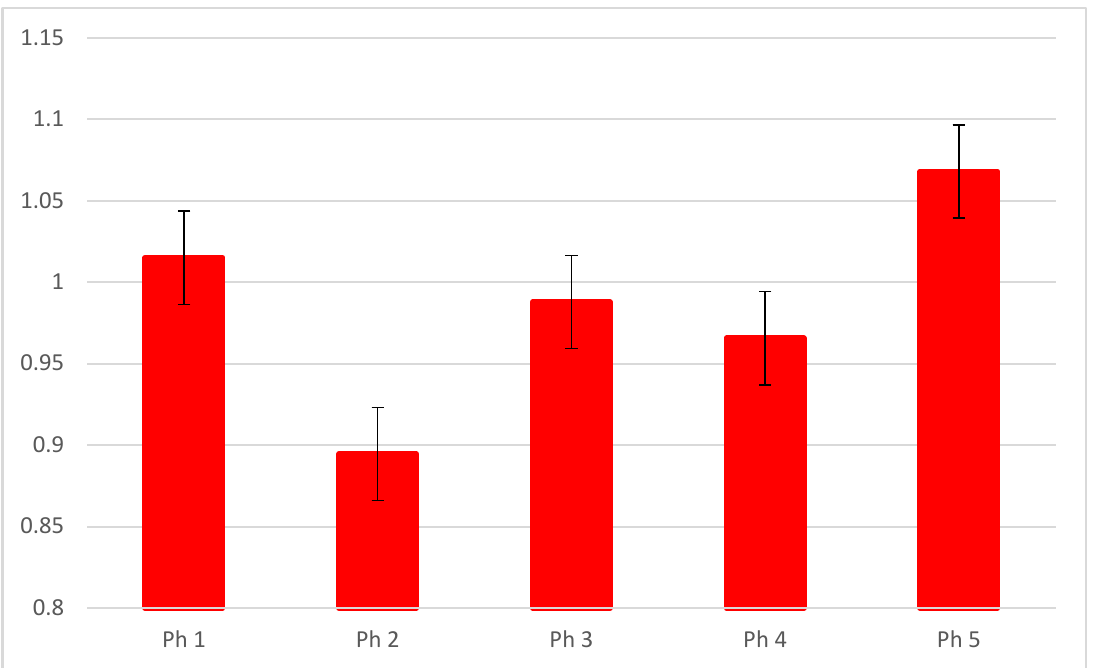
Figure 4. The RT ‐ qPCR analysis of human fetal and postnatal kidneys using primers for mRNA DLG1 and their calculated 2 −∆∆ Ct .